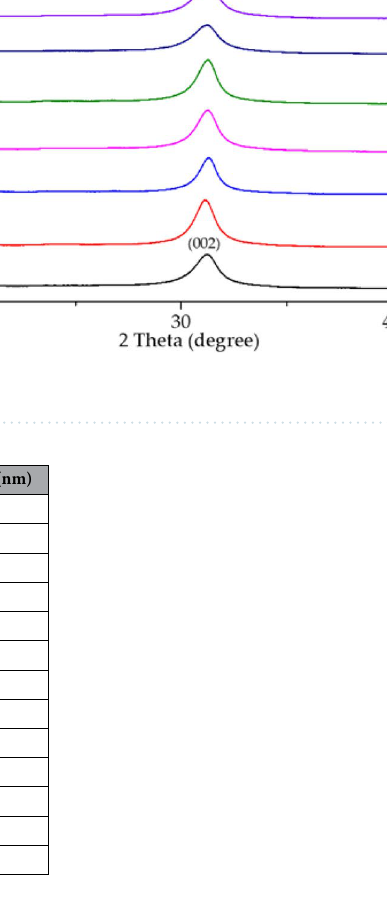
Table 3. Selected XRD characteristics of CN materials.